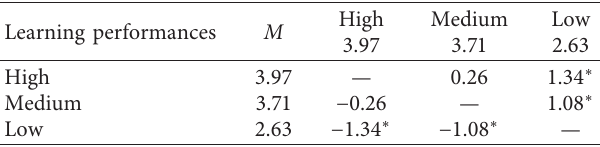
Table 9: Pairwise comparisons of interest in programming among different learning performances.